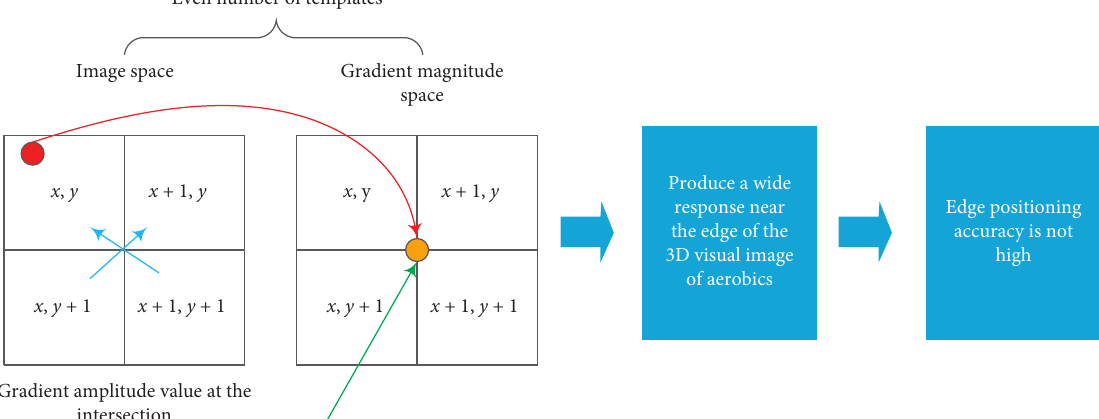
Figure 1: Schematic diagram of Roberts operator